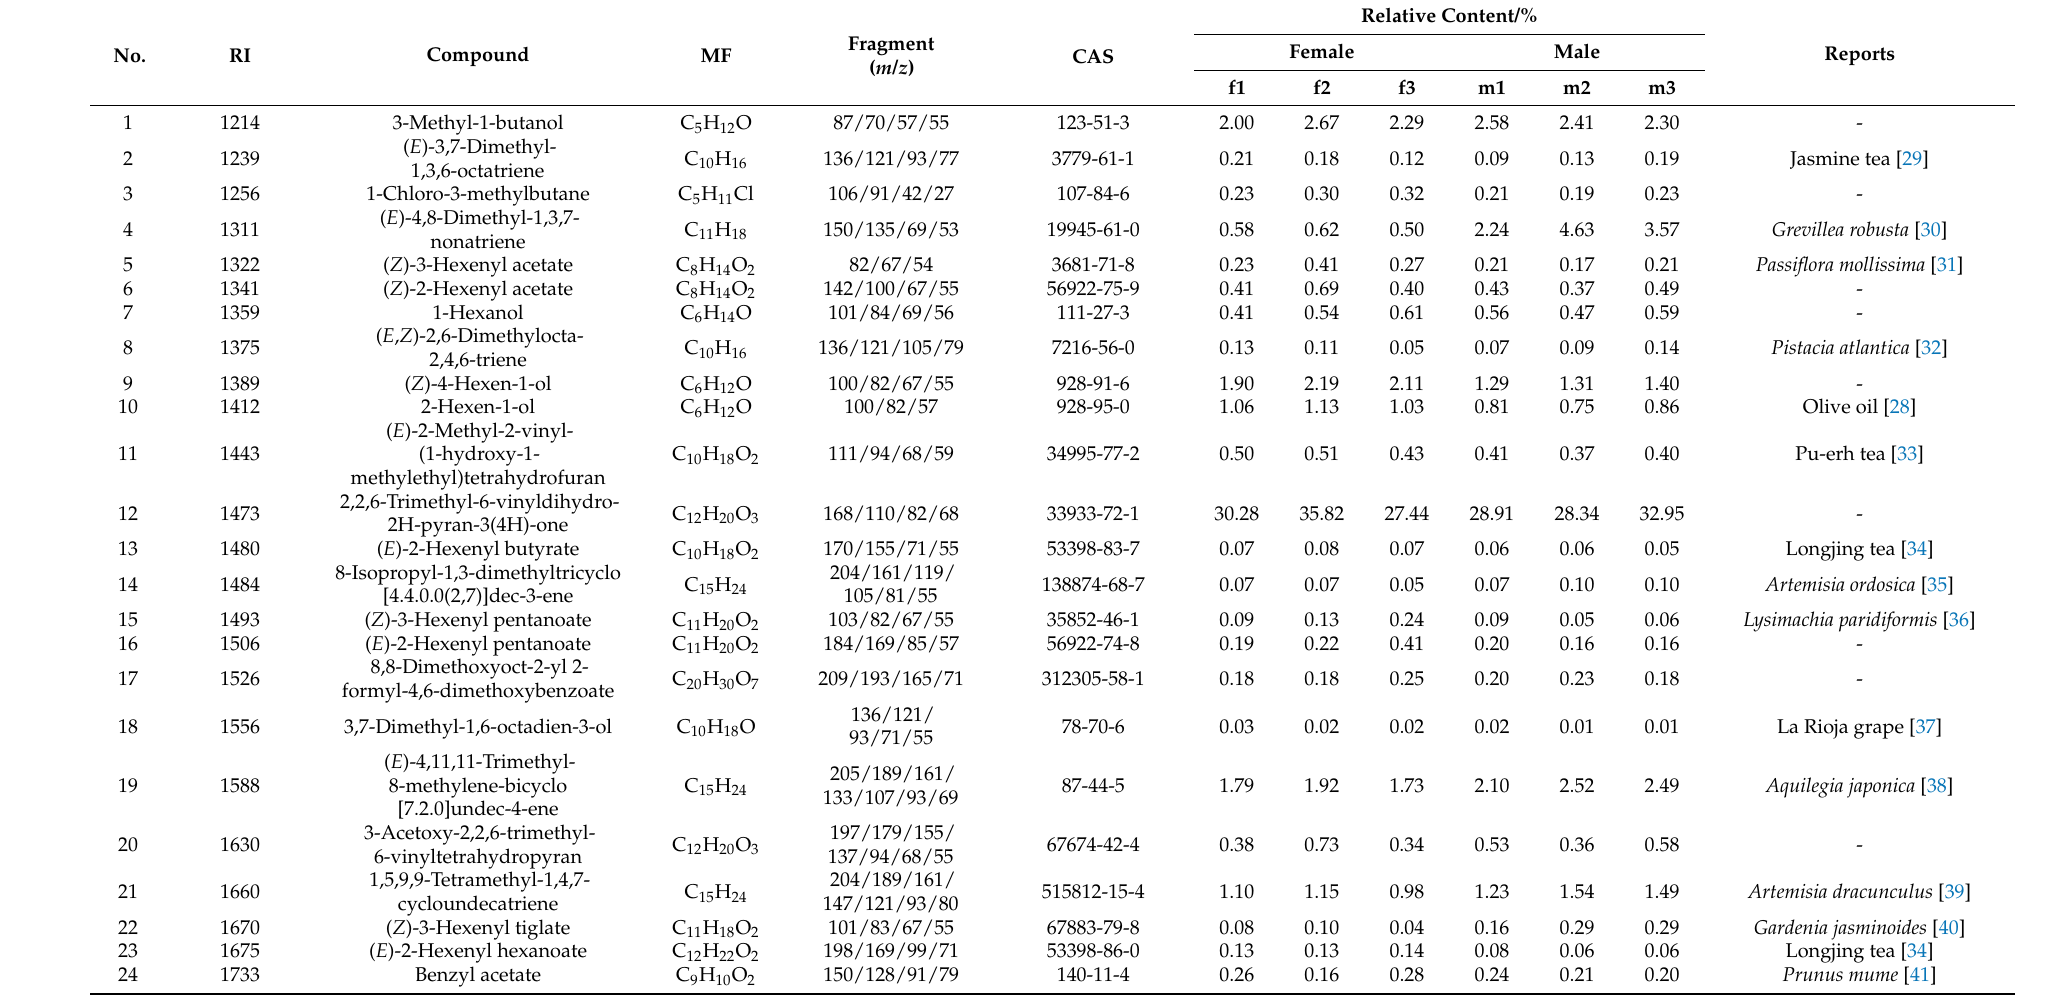
Table 1. Volatile compounds of GC-MS analysis of female and male T. anguina